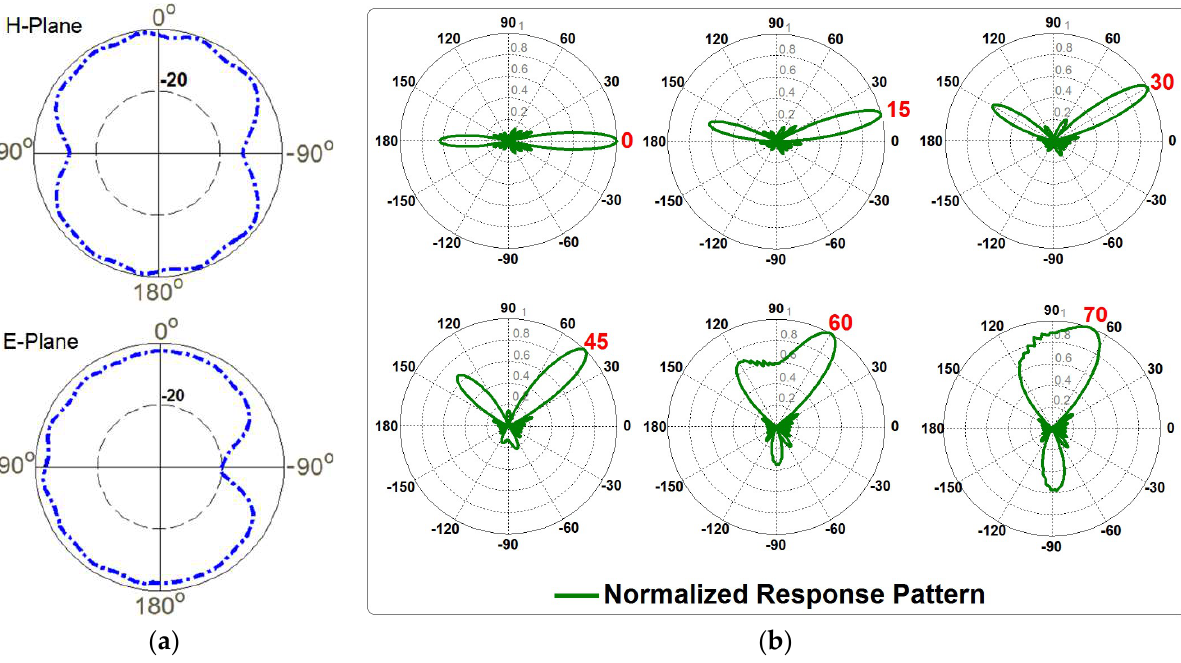
Figure 21. ( a ) Measured radiation patterns and ( b ) synthesized array beams using the single-element experiments. element